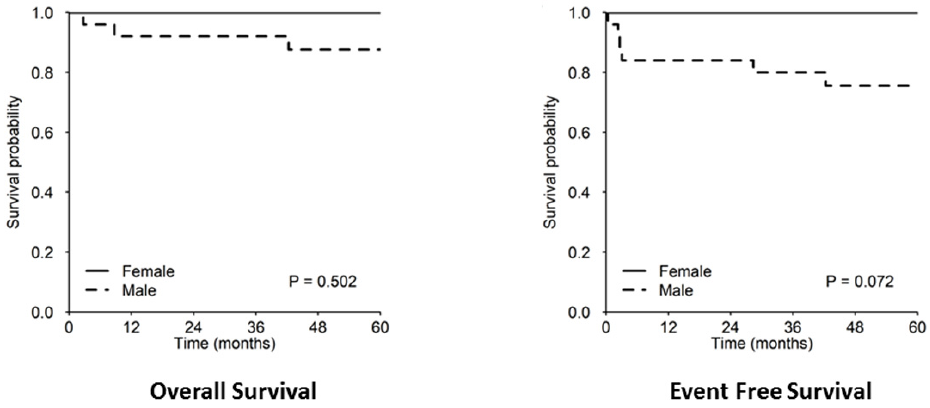
Figure 3. The 5-year OS and EFS rates in B-LBL histology vs. other histology.